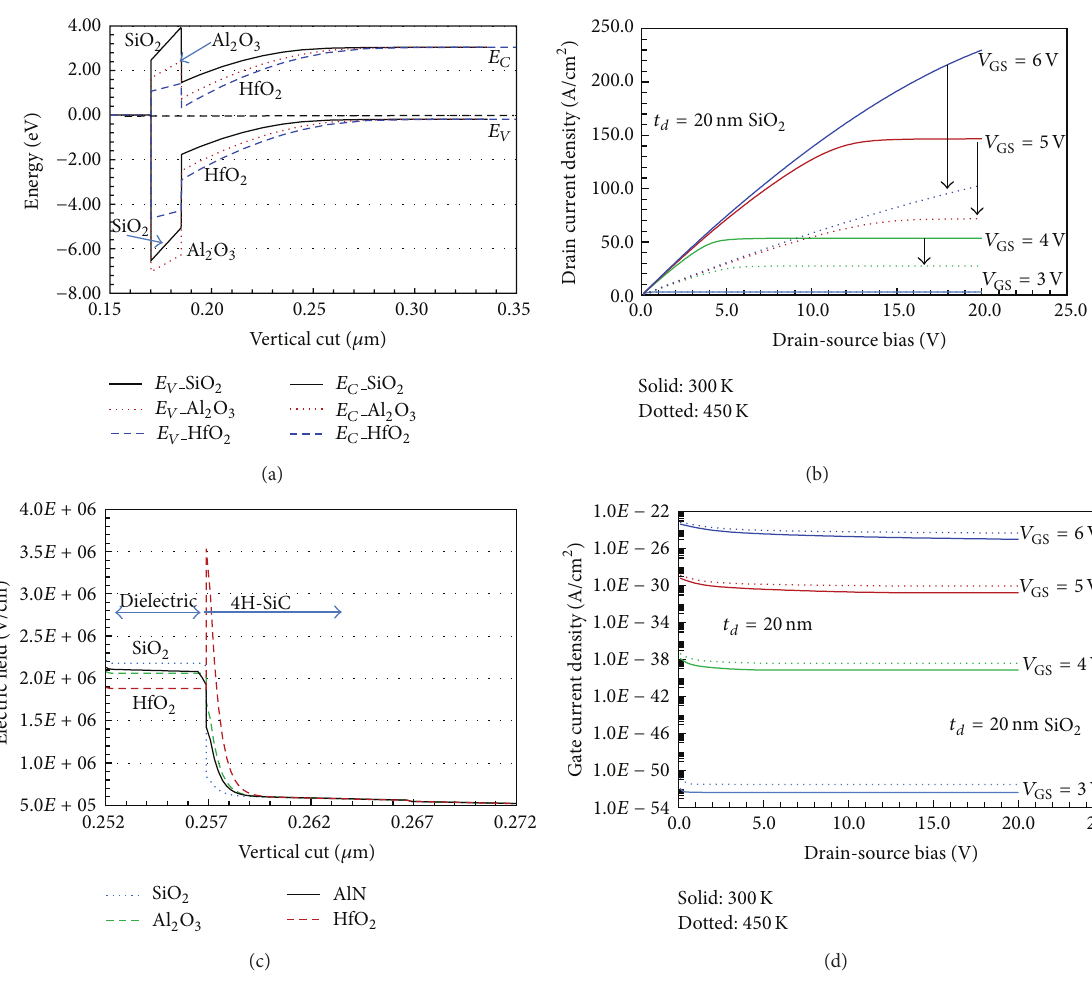
Figure 3: Conduction and valence band energy diagram (a), current-voltage characteristics at different temperatures for 20 nm thick SiO 2 (b), electric field at the semiconductor-dielectric interface for various dielectrics (c), and gate current density at different gate-source biases for 20 nm SiO 2 gate dielectric